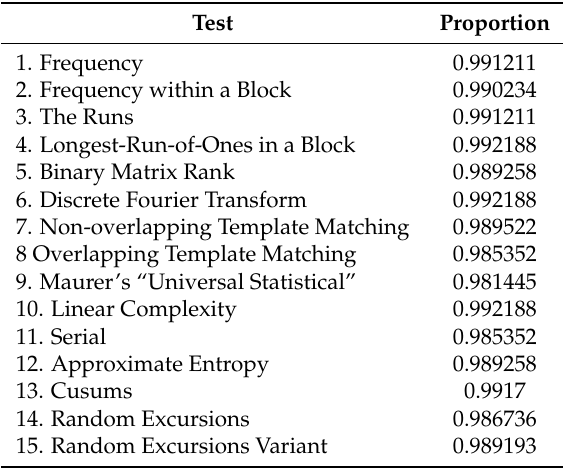
Table 3. Proportion of the 1024 sequences generated by GBPA that passed each STS